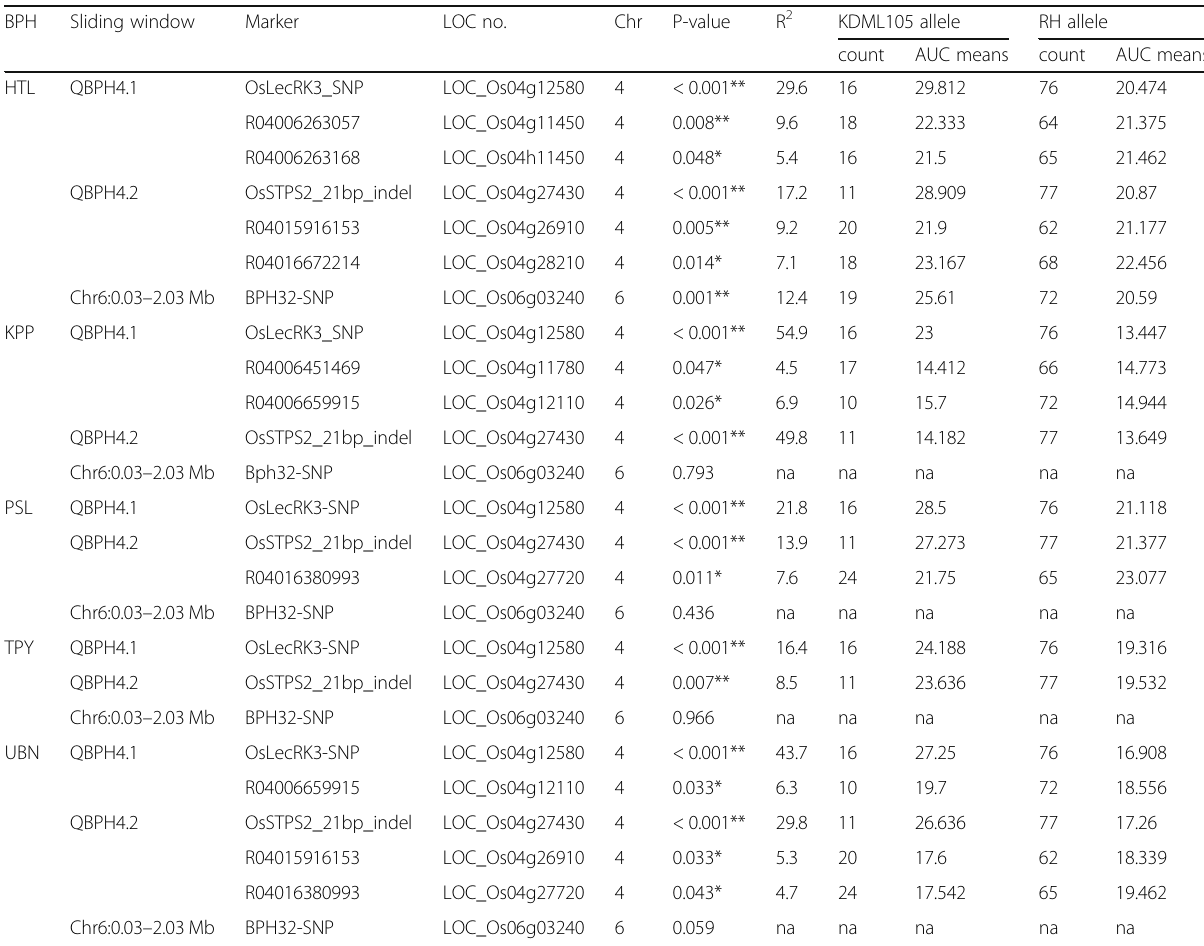
Table 3 Association between markers and BPH resistance in BIL population based on linear regression analysis. Five BPH populations were used, KPP, PSL, UBN, TPY, and HTL. R 2 indicating the proportion of the phenotypic variation contributed by each